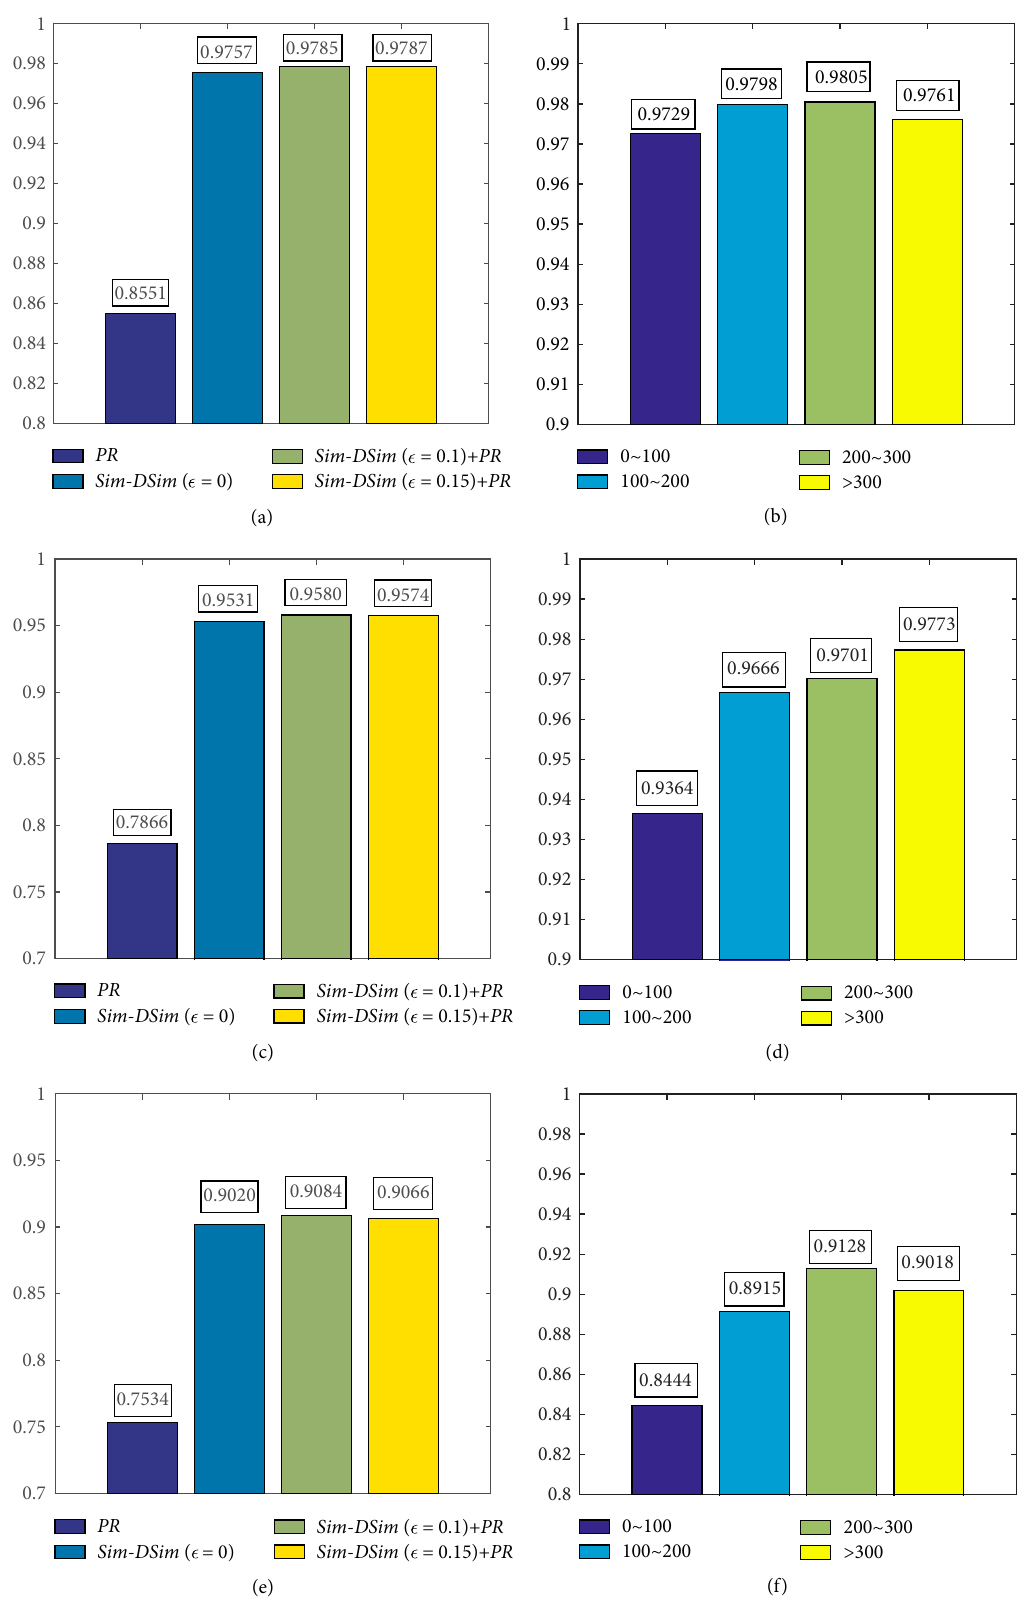
Figure 3: Accuracies comparison with different prediction mechanisms or sets’ size on the three networks. Panels (a), (c) and (e) are accuracies comparison with different prediction mechanisms; and panels (b), (d) and (f) are accuracies comparison with different set size of each network. (a) and (b) Epinions. (c) and (d) Slashdot. (e) and (f)